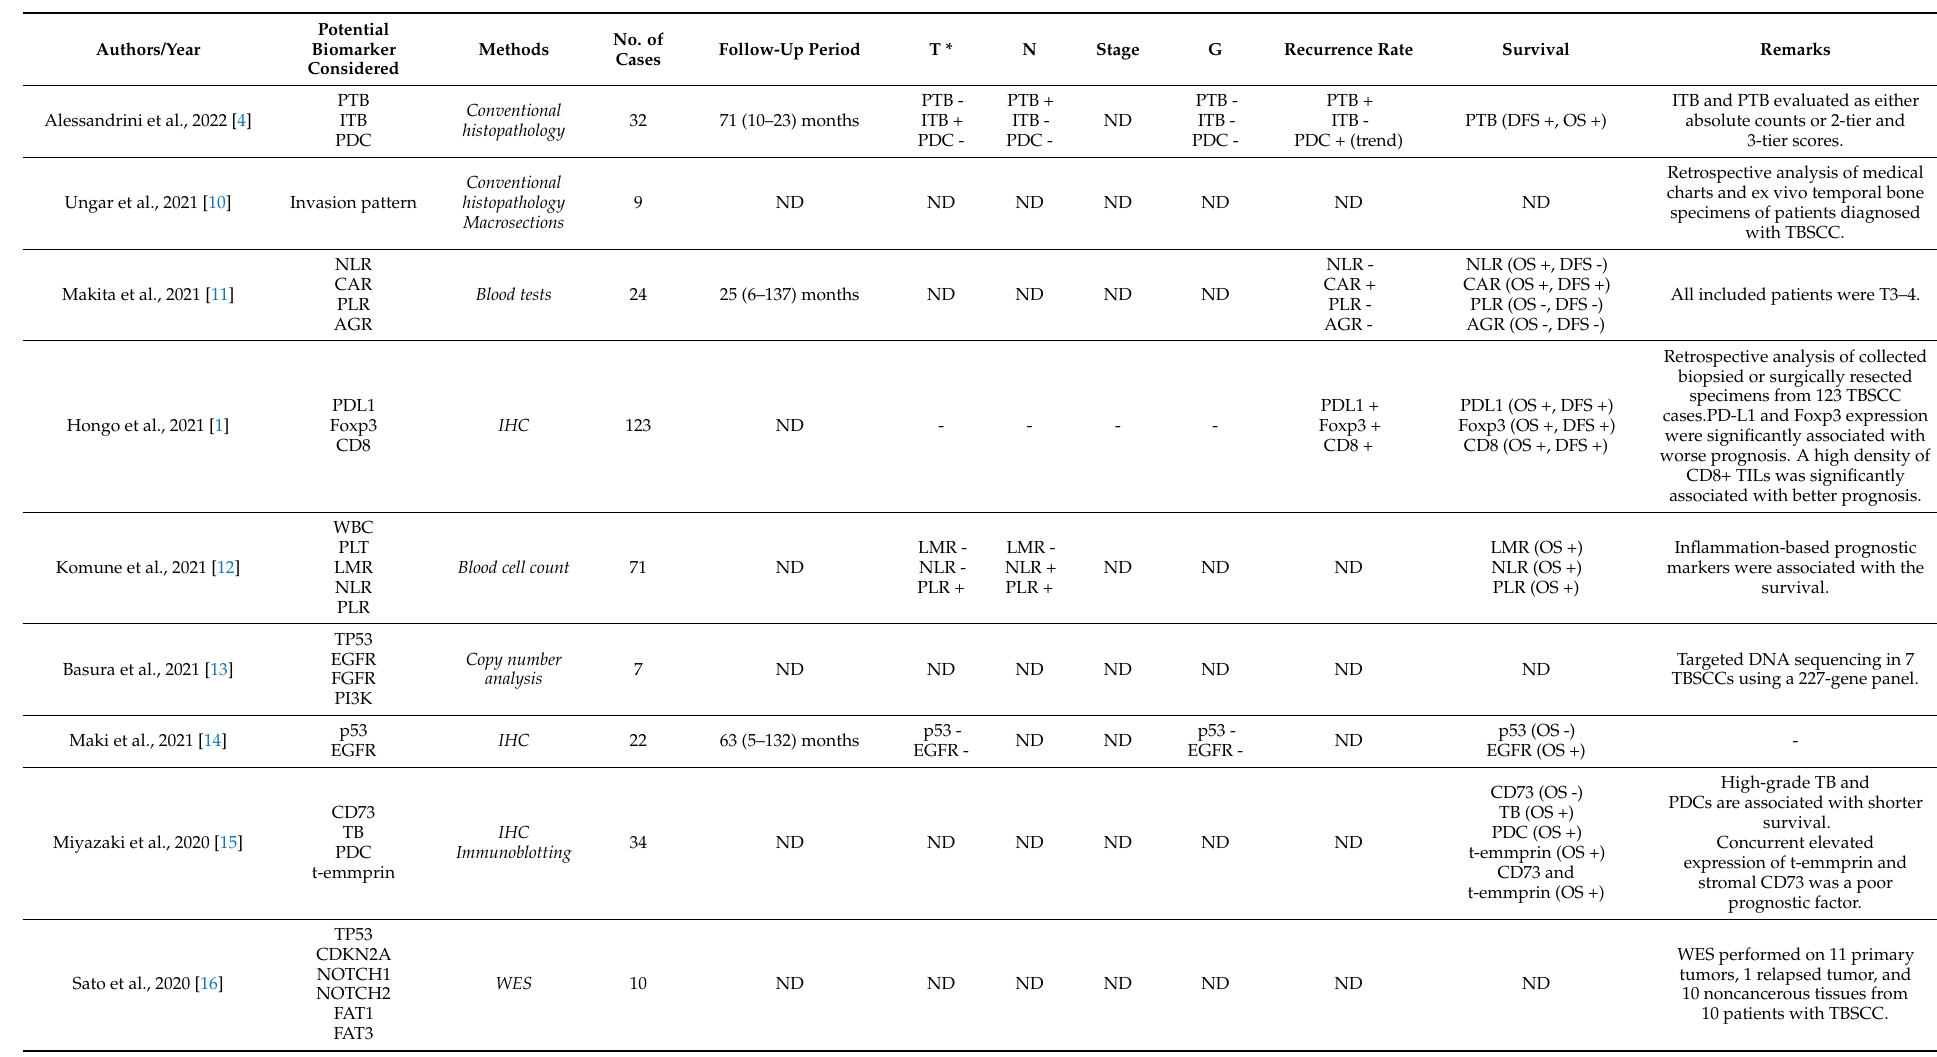
Table 1. Association between biomarker expression, main clinical and pathological variables, and prognosis in